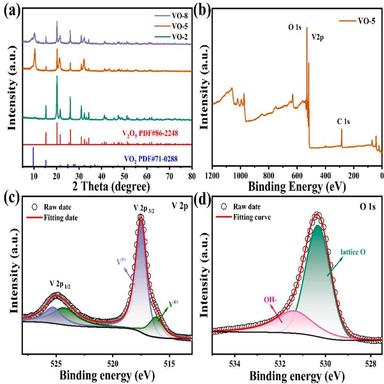
(a) XRD pattern of the VO-2, VO-5 and VO-8. (b) the XPS survey spectrum of VO-5, (c) high-resolution signal fits spectra of V 2p and (d) O 1s.